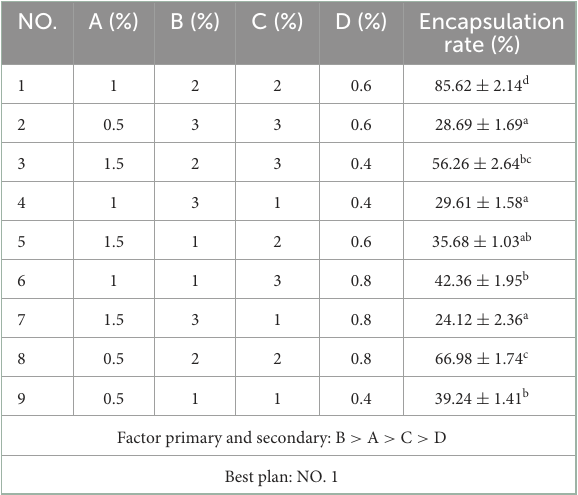
TABLE 1 Orthogonal test parameters of microencapsulated